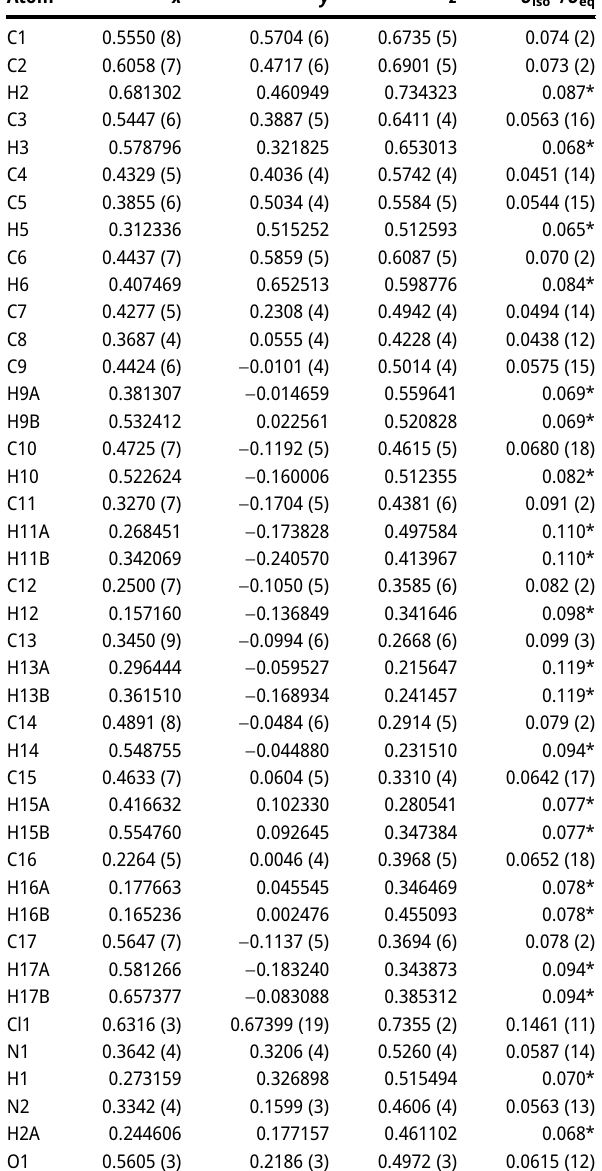
Table  : Fractional atomic coordinates and isotropic or equivalent isotropic displacement parameters (Å 